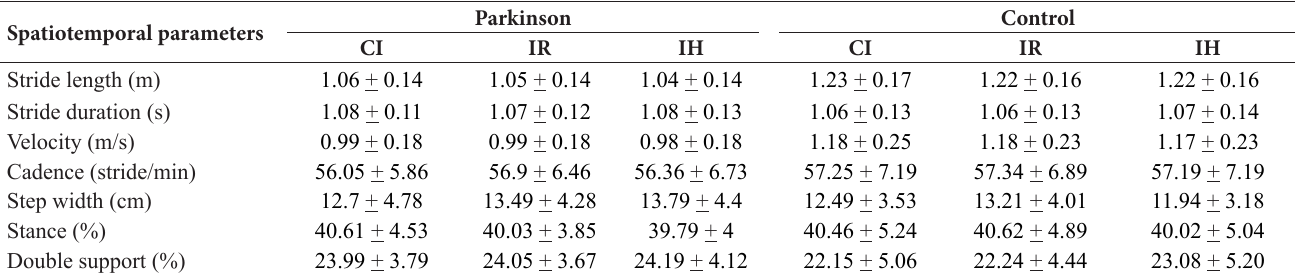
Table 3. Means ± standard deviations of the kinematic variables for both groups (Parkinson and control) in each insole condition (conventional insole, insole with a raised ridge around the foot perimeter and insole with half-spheres). Spatiotemporal parameters